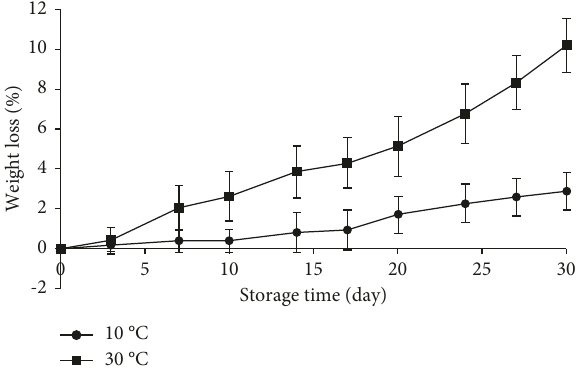
Figure 2: Weight loss of winter melon fruit stored at 10 and 30 ° C.